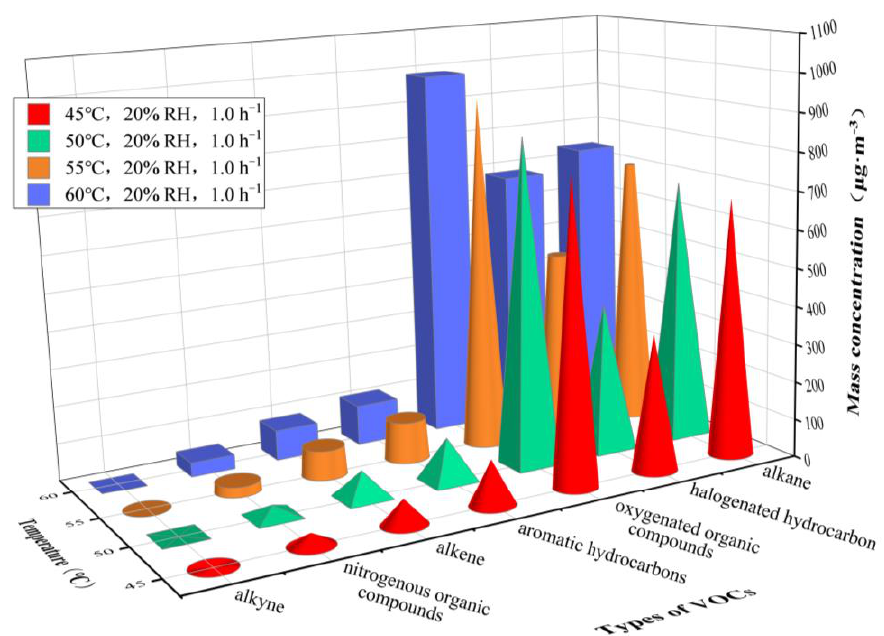
Figure 5. Mass concentrations of VOCs released from plastic track at temperatures varying from 45 to 60 °C. RH = 20% and AER = 1.0 h −1 . Table 2. Mass concentrations of main VOCs released from plastic track under different environmen- tal temperatures.